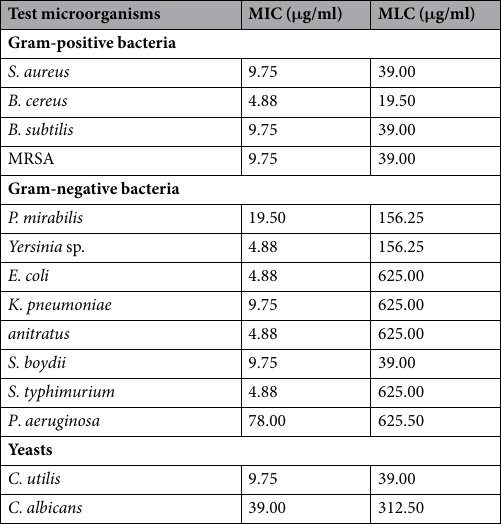
Test microorganisms